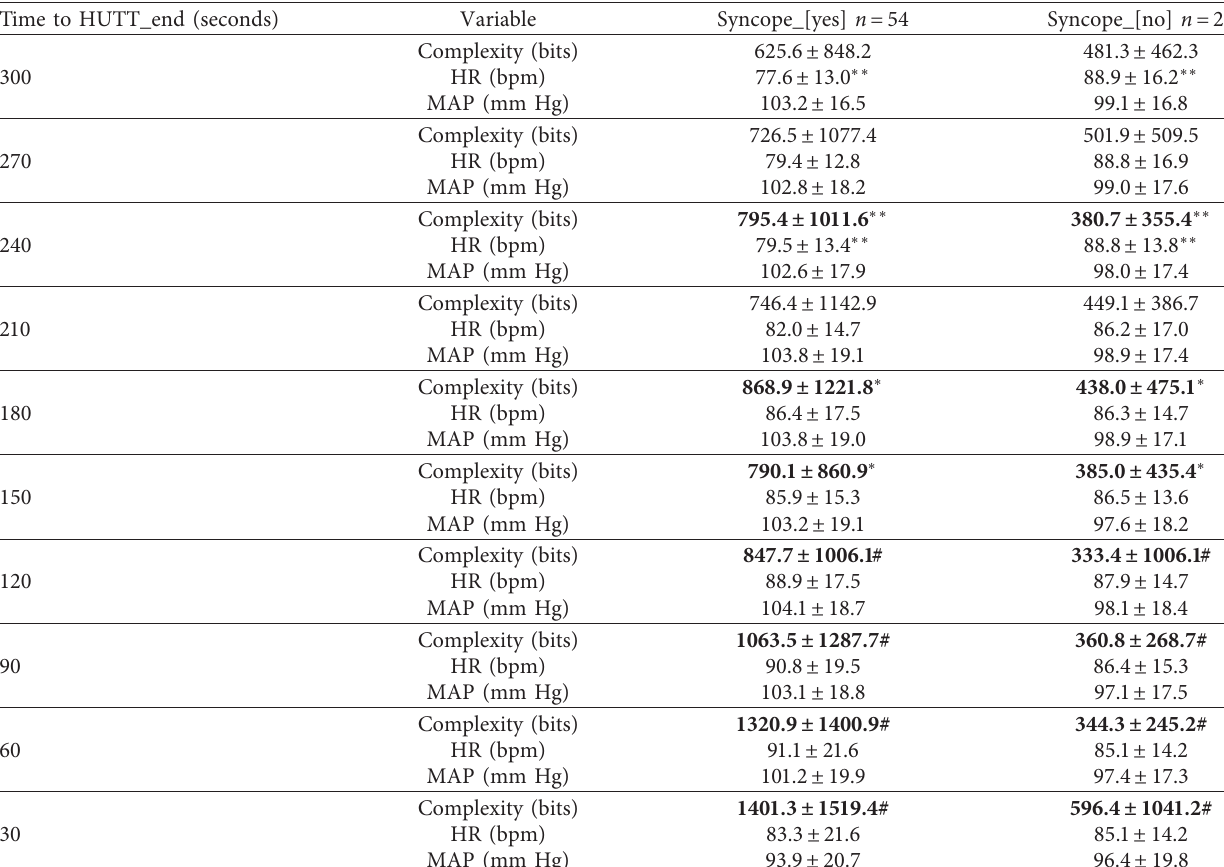
Table 2: Intergroup comparison of complexity, mean arterial pressure (MAP), and heart rate (HR) in the last 300s before the termination of